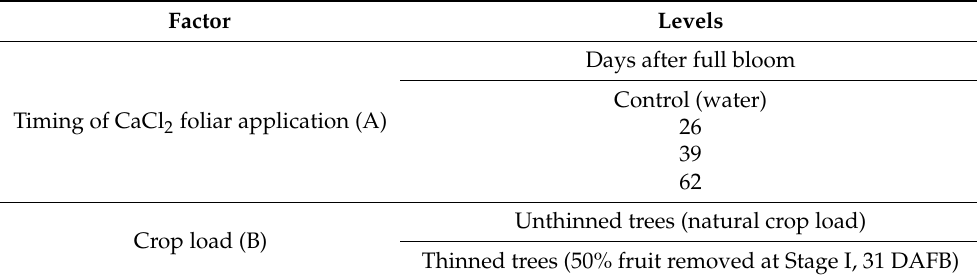
Table 1. Sweet cherry (‘Lapins’/‘Colt’) trained as Kym Green Bush ( n = 80). Factorial design: Factor A: Timing of CaCl 2 foliar application. Factor B: Crop load.